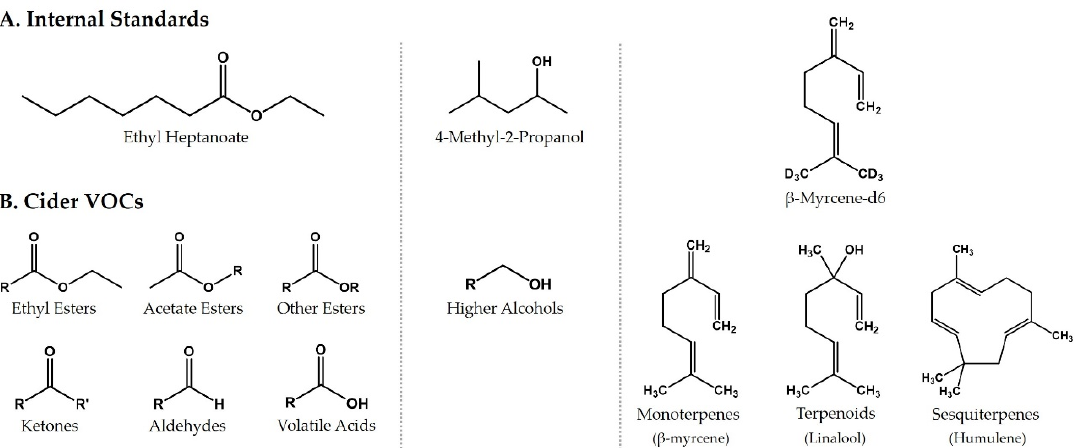
Figure 1. The structures of internal standards ( A ) and key cider volatile organic compounds of importance to this study ( B ).